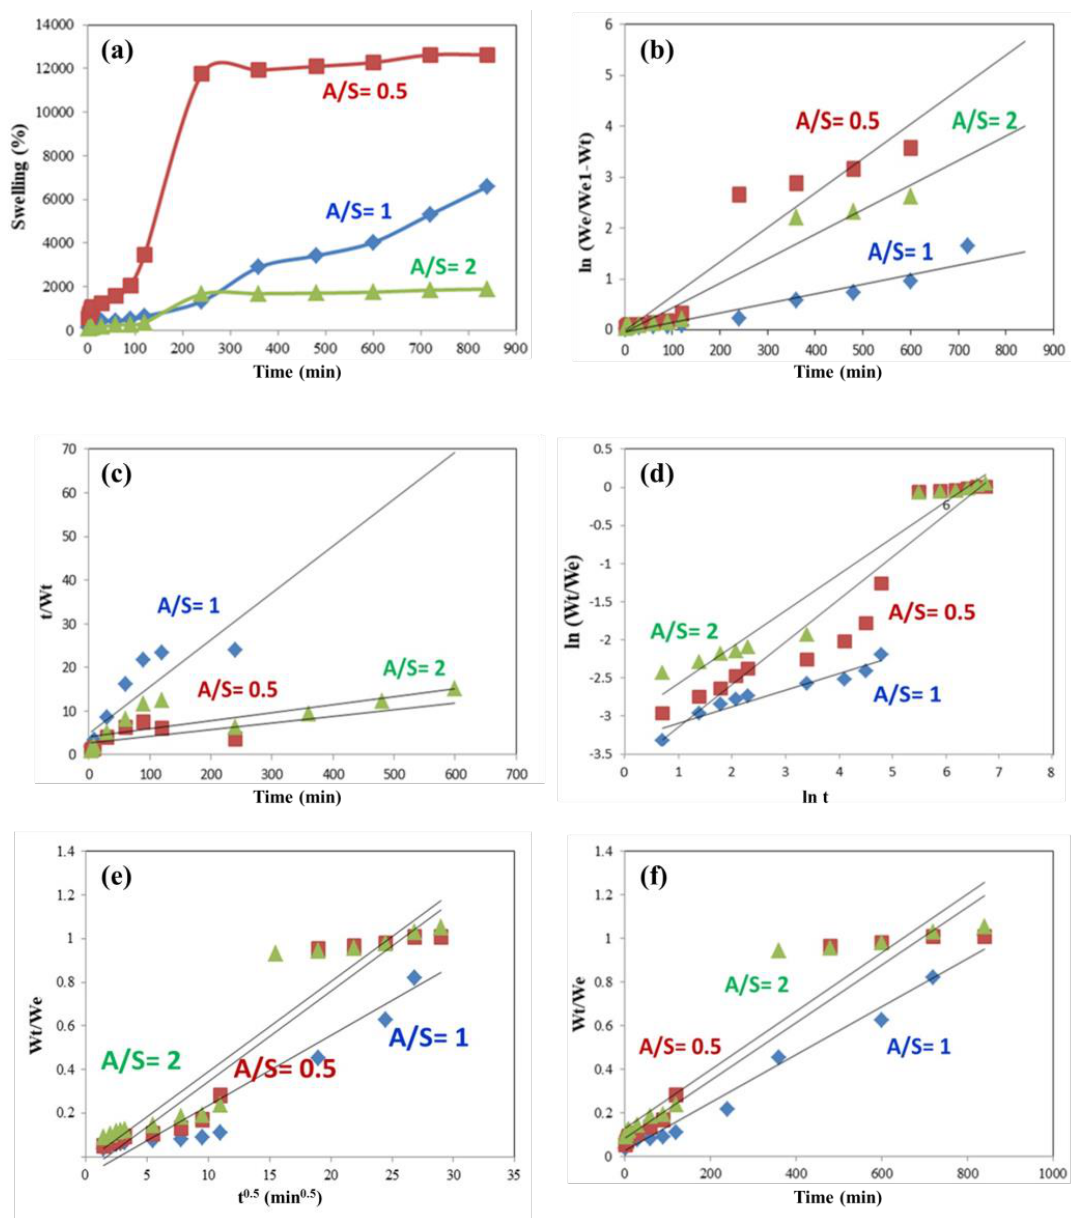
Figure 4. ( a ) Swelling behavior, ( b ) pseudo-first-order, ( c ) pseudo-second-order, ( d ) Peppas and Peppas, ( e ) Fick’s mechanism, ( f ) Peppas and Franson method of HPMC-g-poly(AM-co-SPA) hy- drogels.